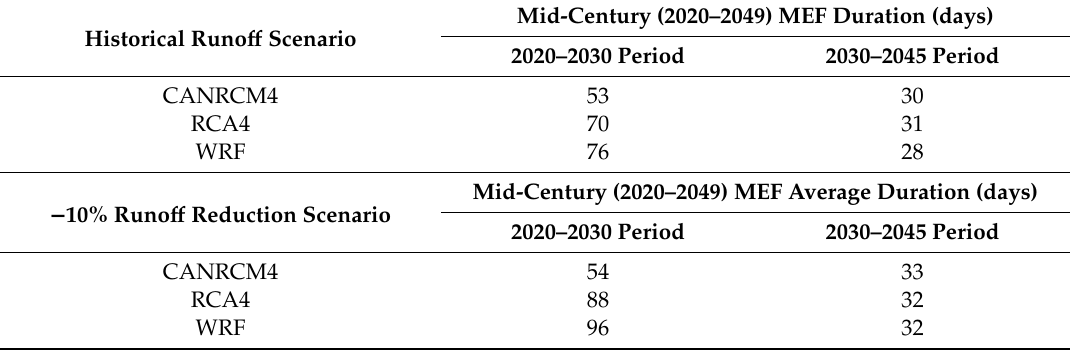
Table 3. Duration of the MEF under historical and − 10% runo ff